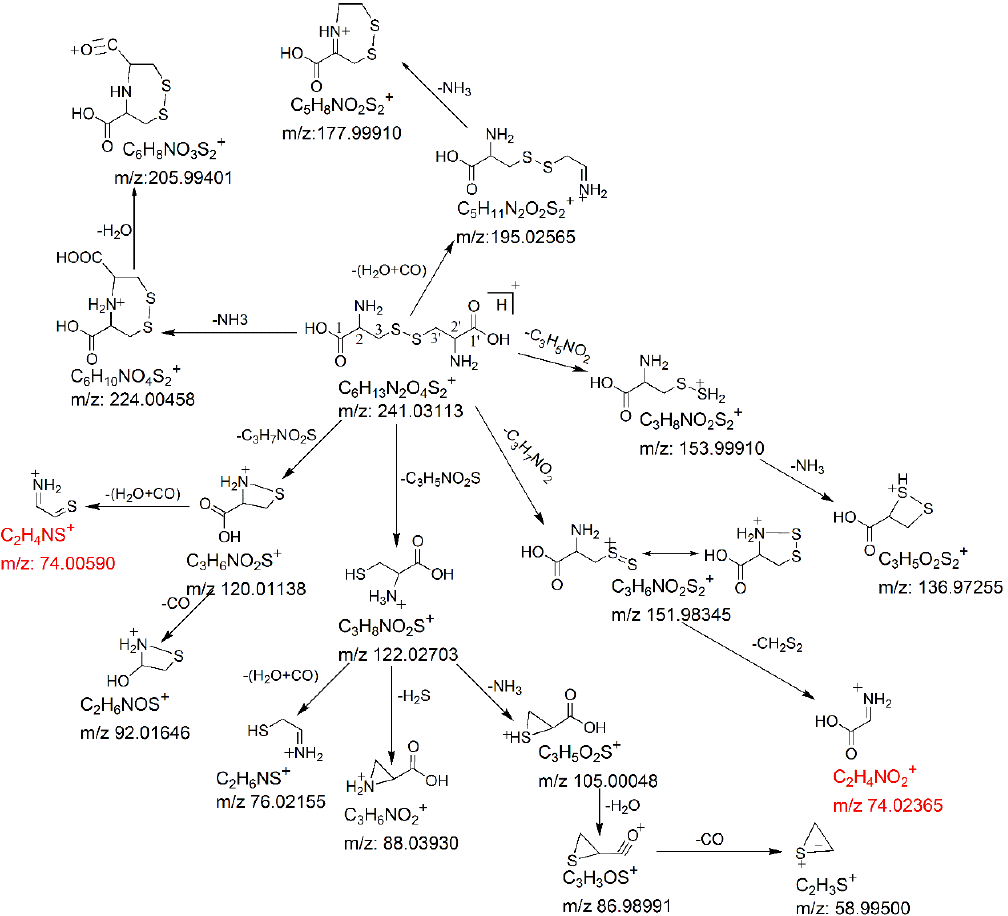
Figure 4. Postulated fragmentation pathways for protonated cystine in CID. The isobaric fragments are shown in red. The m/z values shown are the theoretical masses obtained by calculation.